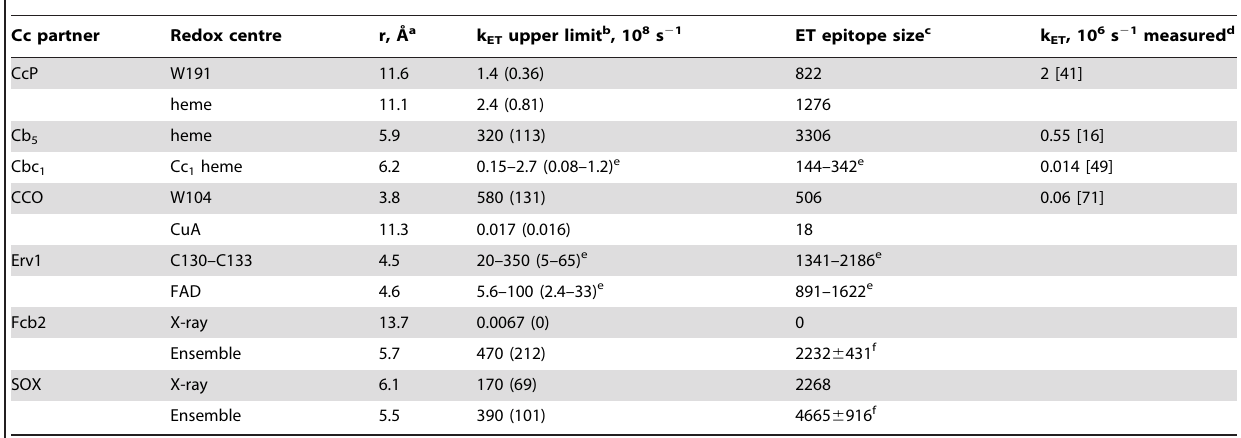
Table 1. ET properties of the Cc complexes modeled in this work.